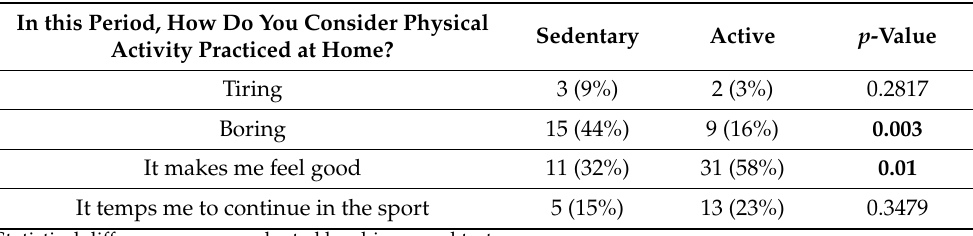
Table 6. Percentages (%) of sedentary and active adolescents with respect of their consideration of physical activity practiced at home during the